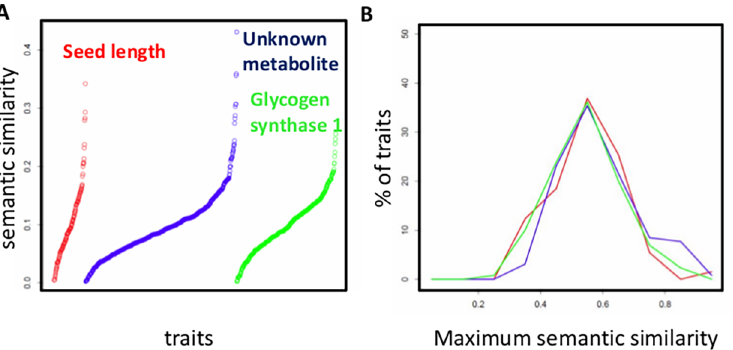
Fig 5. Semantic similarity allows comparisons of traits. (A) Semantic similarity based on BP terms for the macroscopic trait ‘ days to maturity’ with other macroscopictraits (red), metabolitetraits (blue) and expression traits (green). Traits are orderedbased on their semantic similarity to ‘days to maturity’ (left to right, low to high). For each category of traits, the name of the trait with maximum semantic similarity to ‘days to maturity’ is given. (B) Distributionof maximum semanticsimilarity based on BP terms for macroscopictraits with other macroscopic traits (red), metabolictraits (blue), and expression traits